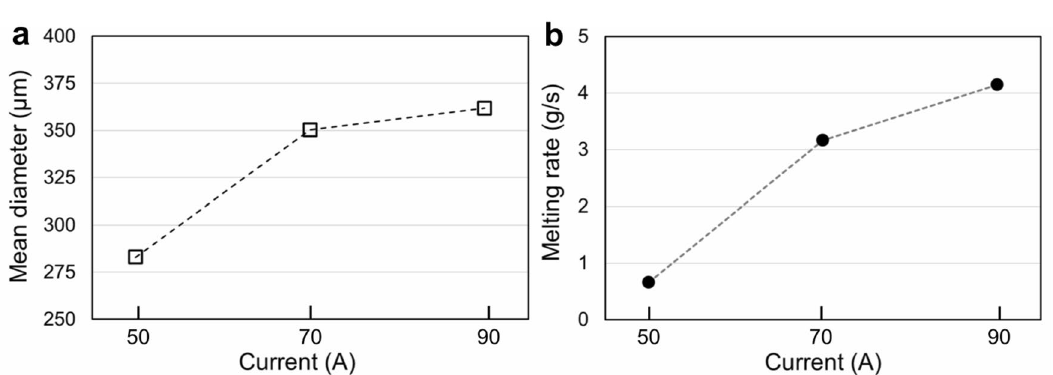
Figure 4. ( a ) Mean diameter of SUS316 powders increased with the increasing arc current. ( b ) The measured melting rate of SUS316 increased with the rising arc